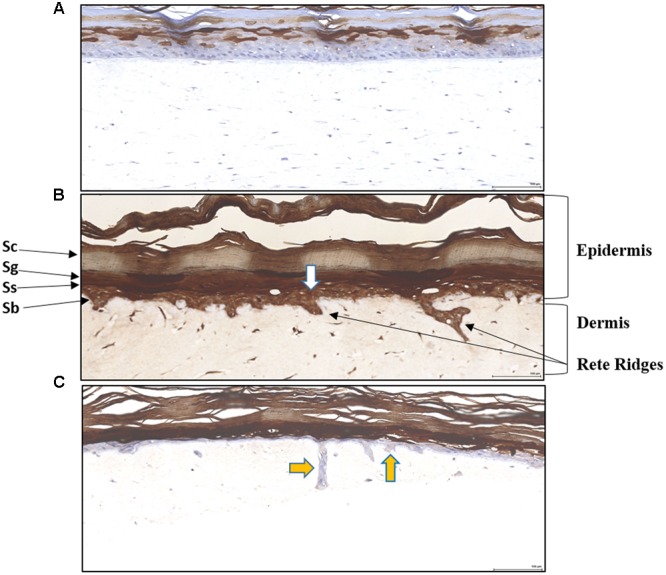
East Indian Sandalwood Oil treatment results in expression level and cellular distribution pattern of psoriasin. Vehicle-treated reconstituted normal epidermal tissue model (A), vehicle-treated (B), and EISO-treated reconstituted psoriatic skin model (C). Psoriasin is localized in hyperplastic epidermis and reduced after 8 days of EISO treatment at 0.002% (yellow arrows). Scale bar = 100 μm